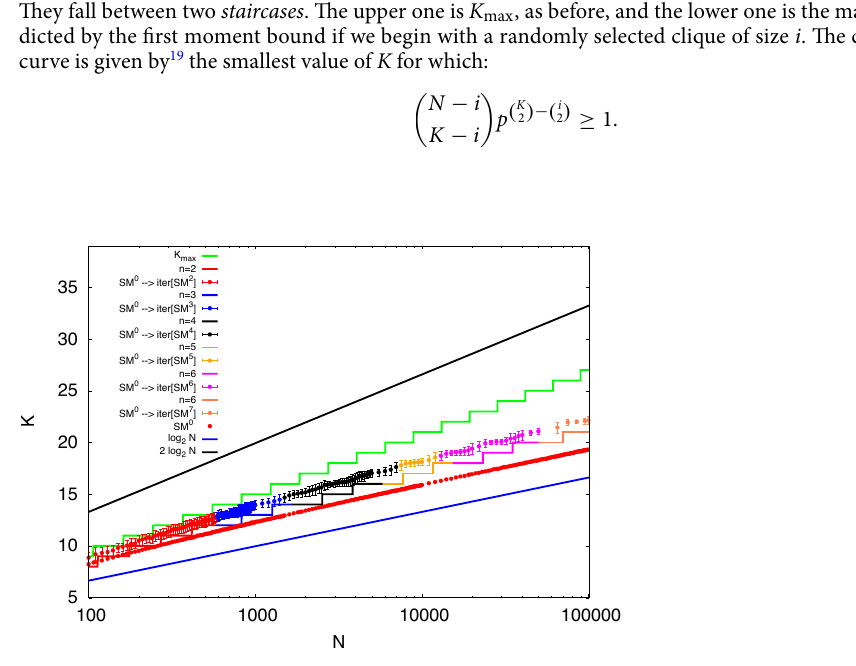
0.5 ) . The green staircase is K max , as = iter SM i , using → [ ]